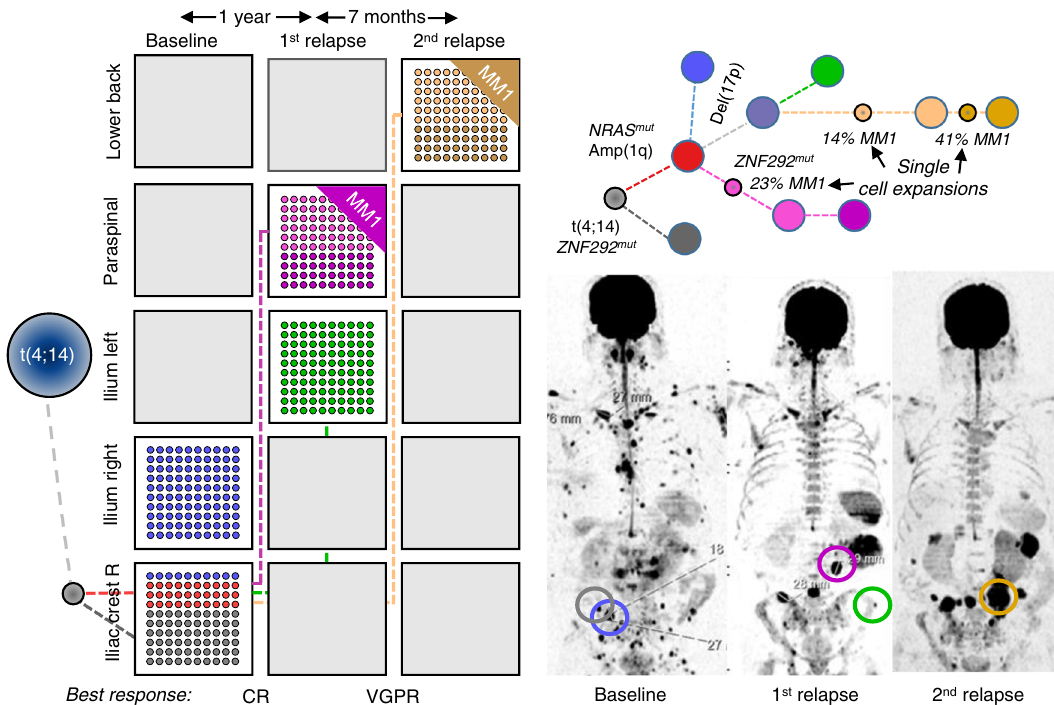
“ green ” branch are interconnected by a pink and green dashed line, respectively. Knownmyelomadriversaremarkedinbold.Thetreeisalignedwiththefunctional imaging plots and as such, the length of branches does not indicate the extent of subclonal differences. A timeline of treatment and sampling alongside a detailed mockoncogenetictreeisshowninSuppl.Fig.25.VGPRverygoodpartialremission, CR complete remission. Source data are provided as a Source Data fi